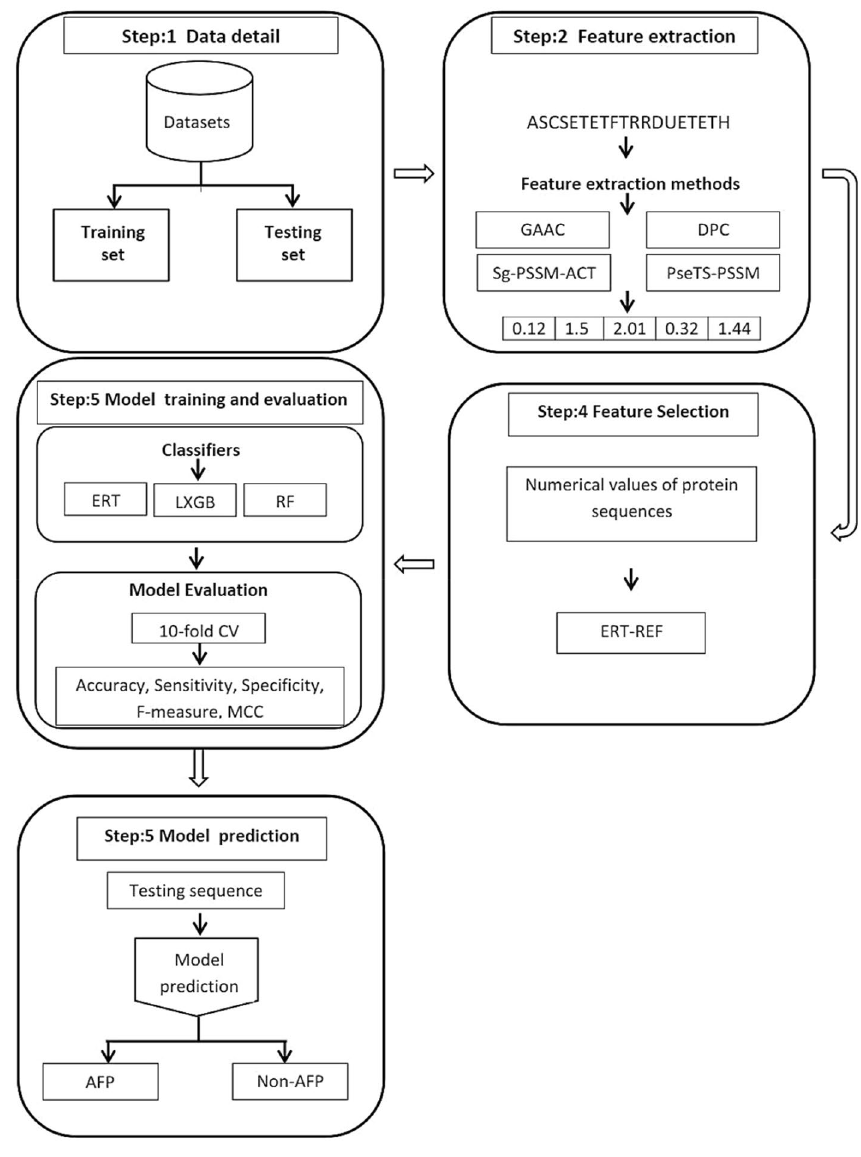
Figure 1. Pipeline of the